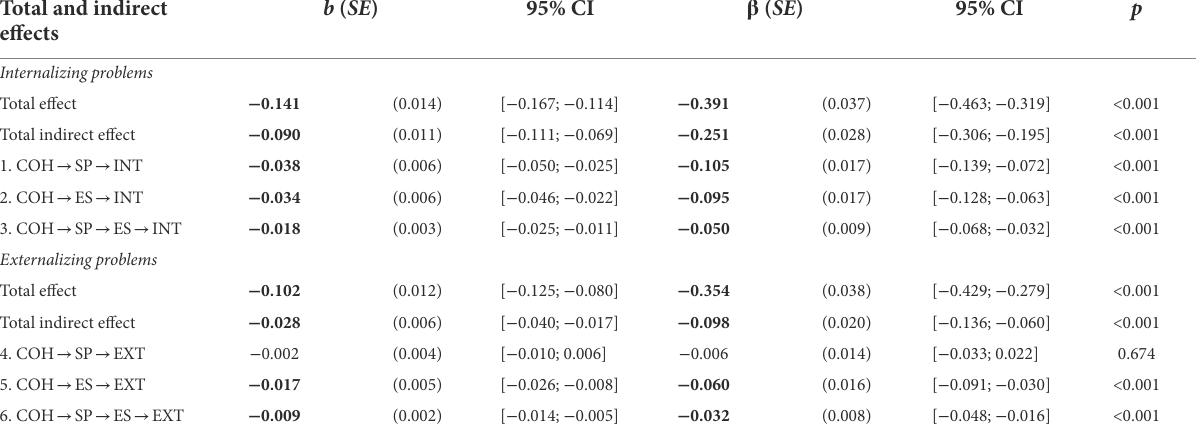
TABLE 4 Indirect effects of the path model.